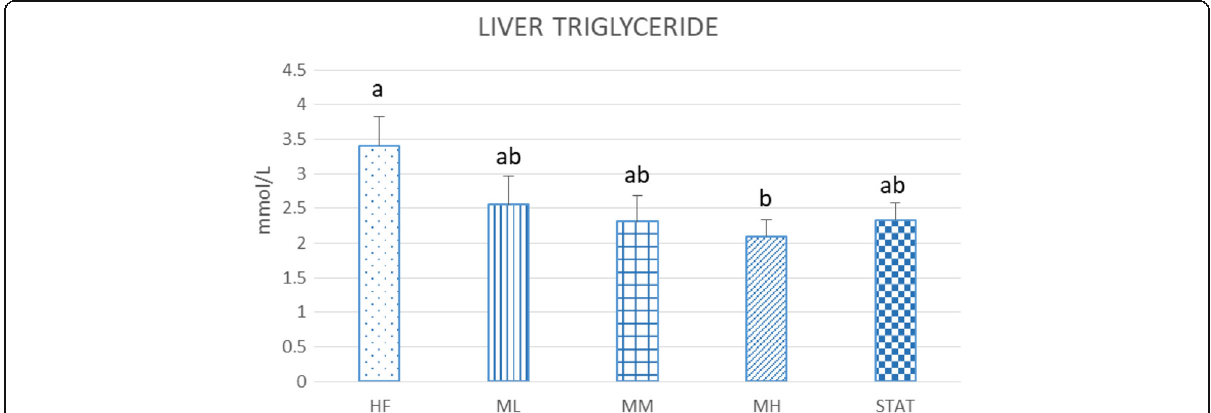
Fig. 3 Effect of Maoberry juice on the levels of liver TG ( n = 12). The groups were classified as follows: high fat diet with no treatment (HF); three